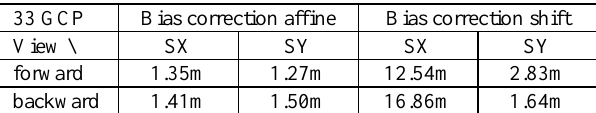
Table 5. Standard deviations of Cartosat-1 GCP based on RPC- image orientations improved by bias correction with affine